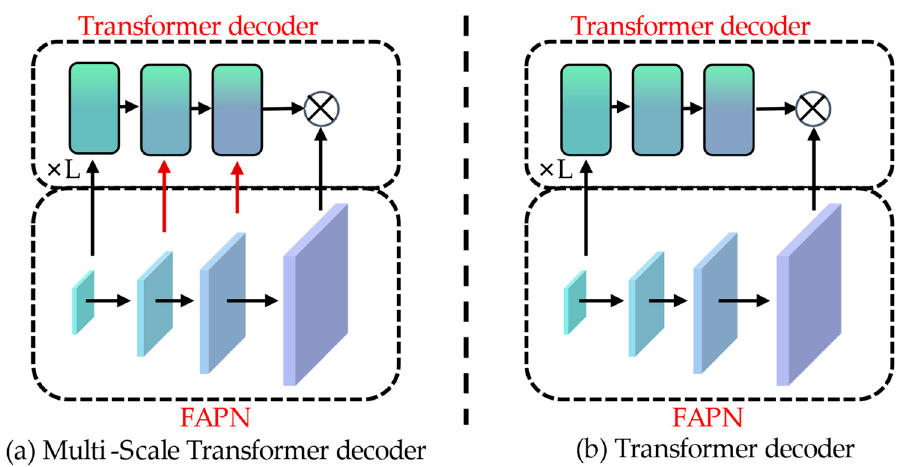
Figure 5. Decoder structure comparison. ( a ) Multi-Scale Transforemr decoder. ( b ) Transformer decoder.